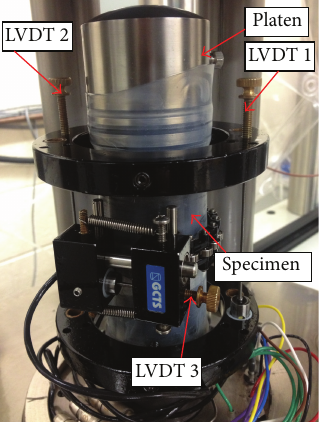
Figure 3: The layout of all 3 linear variable differential transformers